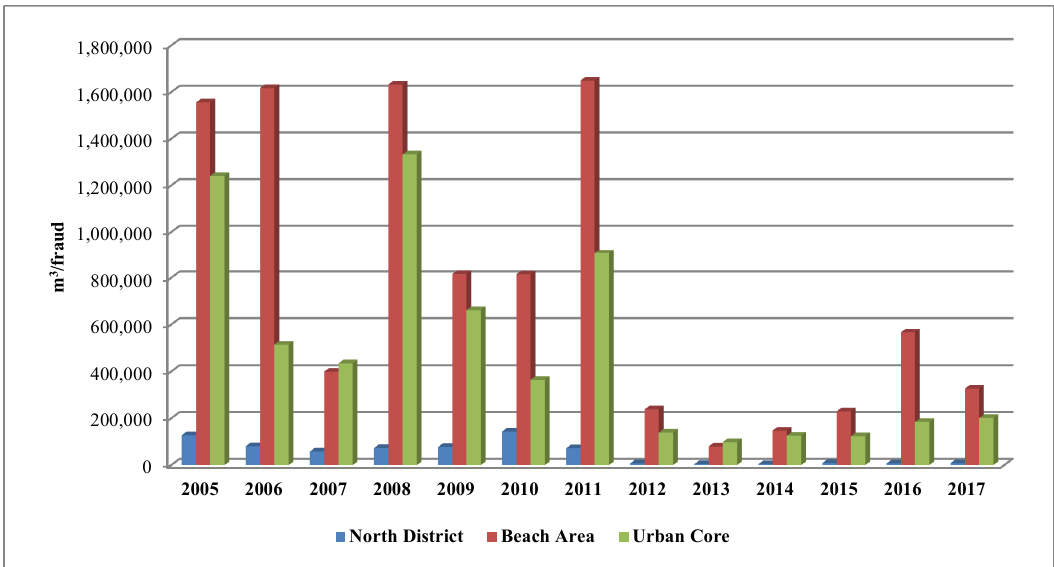
Figure 6. Evolution of the ratio of domestic water supply (m 3 )/frauds detected in the compact urban model (2005–2017). Source: AMAEM. Own elaboration. Water 2018 , 10 , x FOR PEER REVIEW